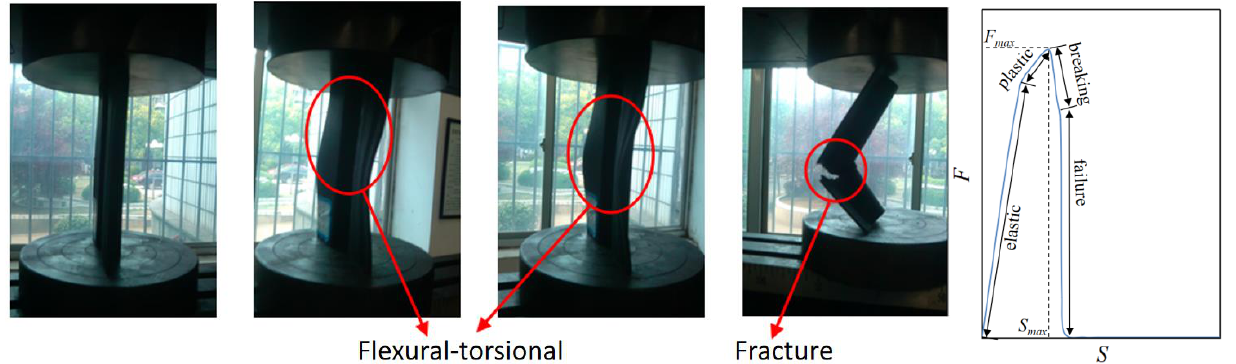
Figure 3. The typical deformation process, failure behavior, and force – displacement relationship of the specimens under compression ( S : displacement, F : force, F max : peak force, S max : displacement at the instant of F max ).